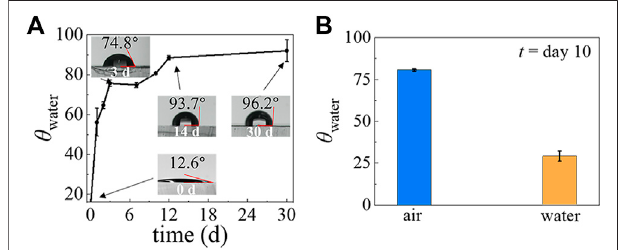
FIGURE 2 | The temporal evolution of PDMS surface hydrophilicity after plasmatreatmentwhenstoredinairandwhenstoredinwater. (A) The θ water of the PDMS surface stored in ambient laboratory conditions, measured at different time points. (B) The θ water of the PDMS surface after storage in air and in water for 10